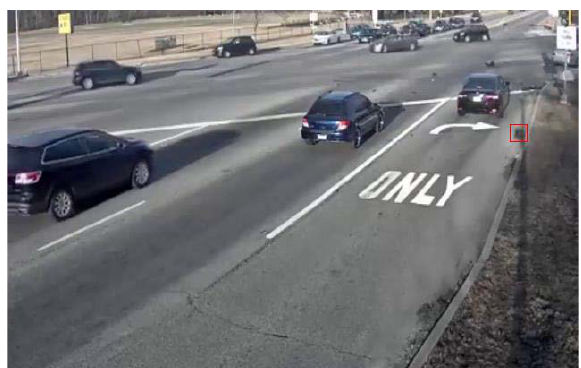
Fig. 7. The same as Fig. 6 but for another frame containing vehicles collision.